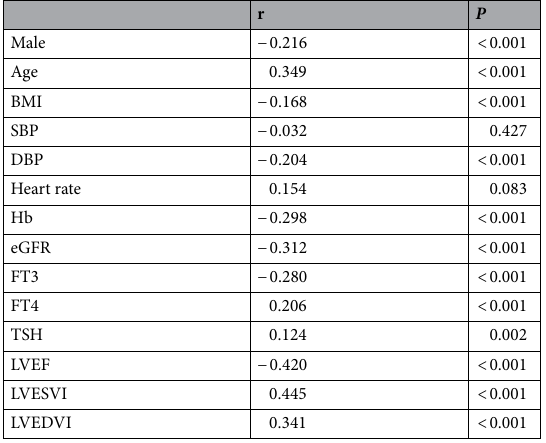
Table 3. Spearman’s rank correlation coefficients between the BNP level and various clinical factors (n = 625). BNP, B-type natriuretic peptide; BMI, body mass index; SBP, systolic blood pressure; DBP, diastolic blood pressure; Hb, hemoglobin; eGFR, estimated glomerular filtration rate; FT3, free triiodothyronine; FT4, free thyroxine; TSH, thyroid-stimulating hormone; LVEF, left ventricular ejection fraction; LVESVI, left ventricular end-systolic volume index; LVEDVI, left ventricular end-diastolic volume